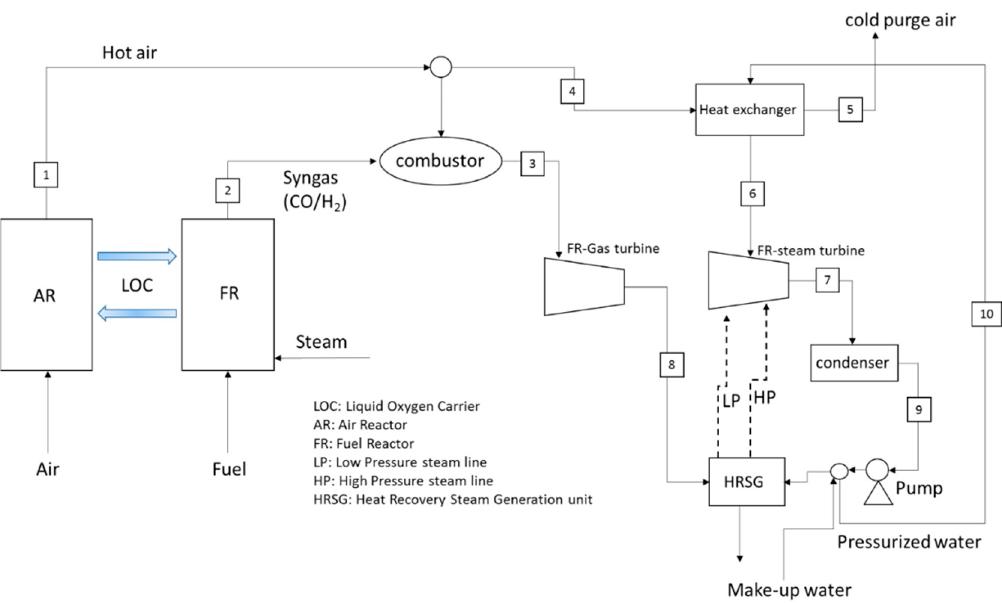
Figure 1. Configuration of the proposed power block to be integrated with a liquid chemical looping gasification (LCLG) system (integrated gasification combined cycle—IGCC).